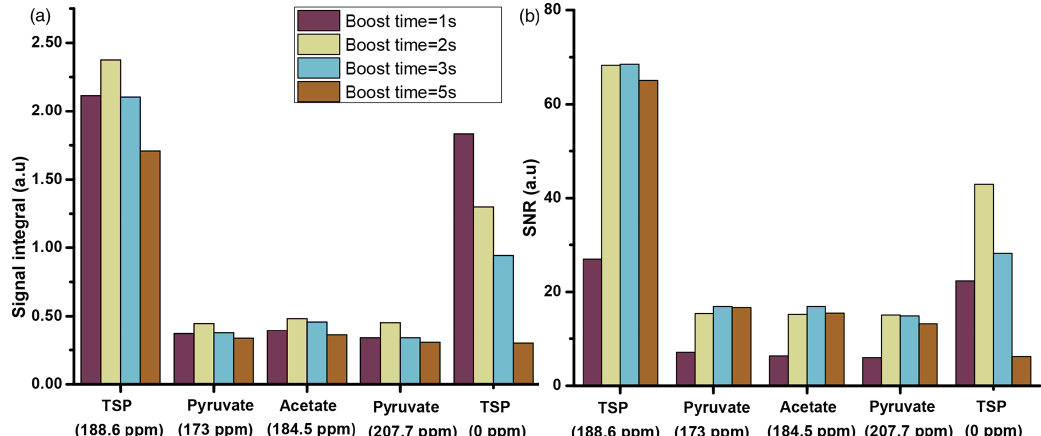
Figure 5. Plot of liquid-state hyperpolarized 13 C– { 1 H } signal integrals (a) and SNR (b) of the metabolites at different boost times using optimized µw and solid-state DNP parameters using a transfer line with 1.575mm ID and D 2 O as dissolution solvent. The optimum value of boost time is chosen to be 2s.